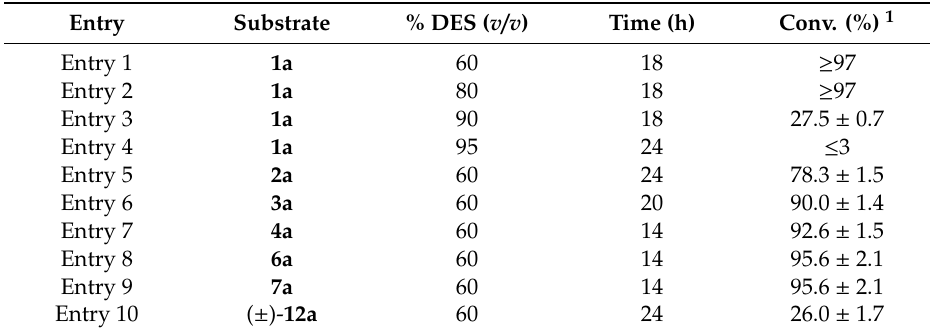
Table 3. HMFO-biocatalyzed oxidations of aromatic alcohols (Tris/HCl 50 mM, pH 8.0, 30 °C) using Glu:Fru:H 2 O (1:1:6) 1